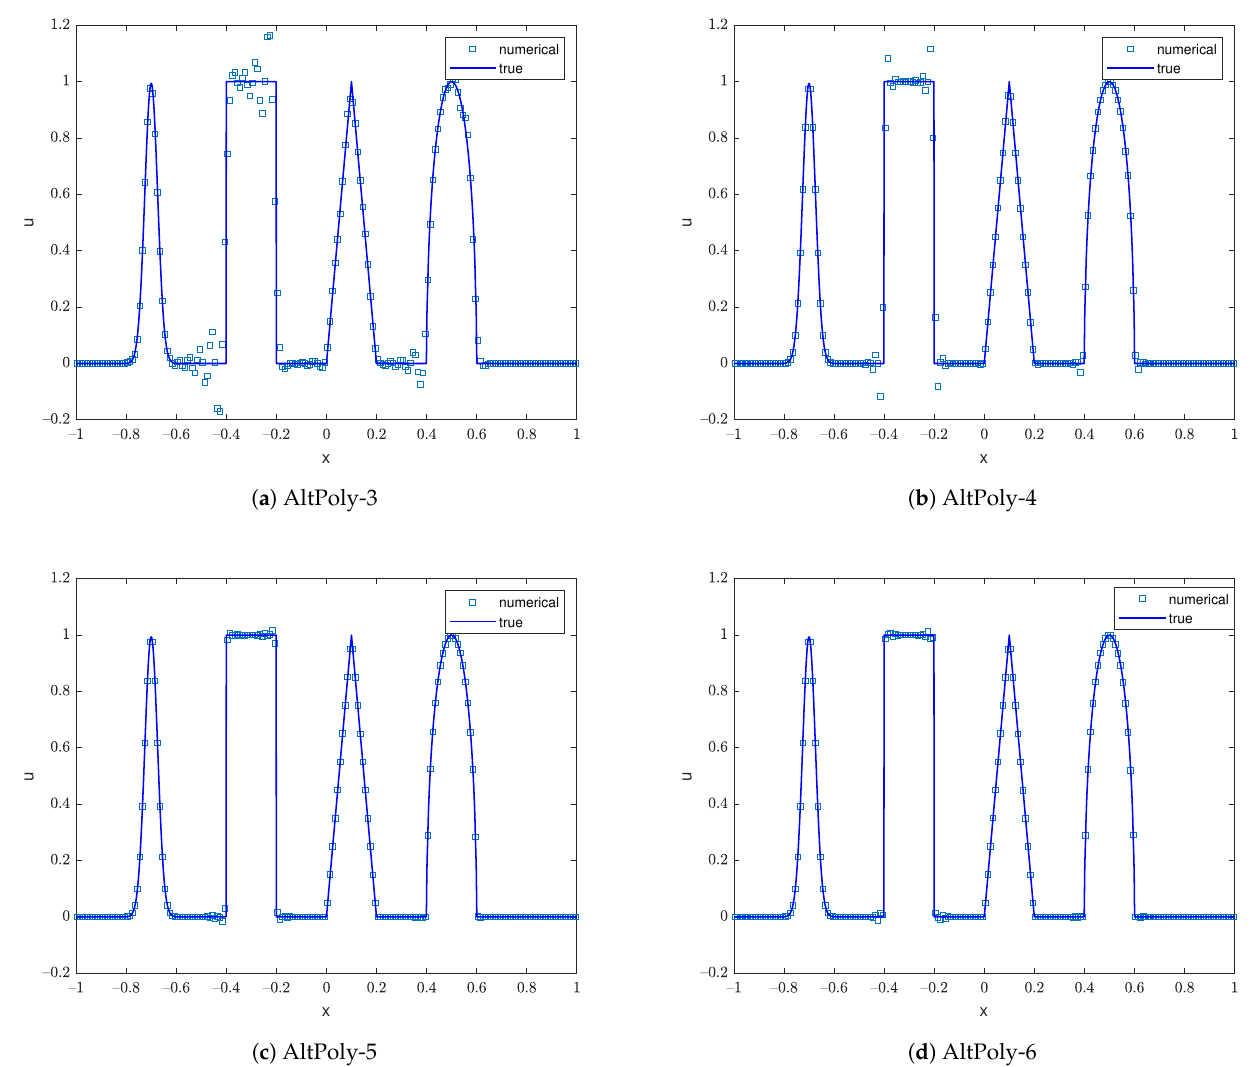
Figure 3. Numerical results of the advection of a complicated profile at t = 2 via AltPoly without artificial viscosity using N = 200